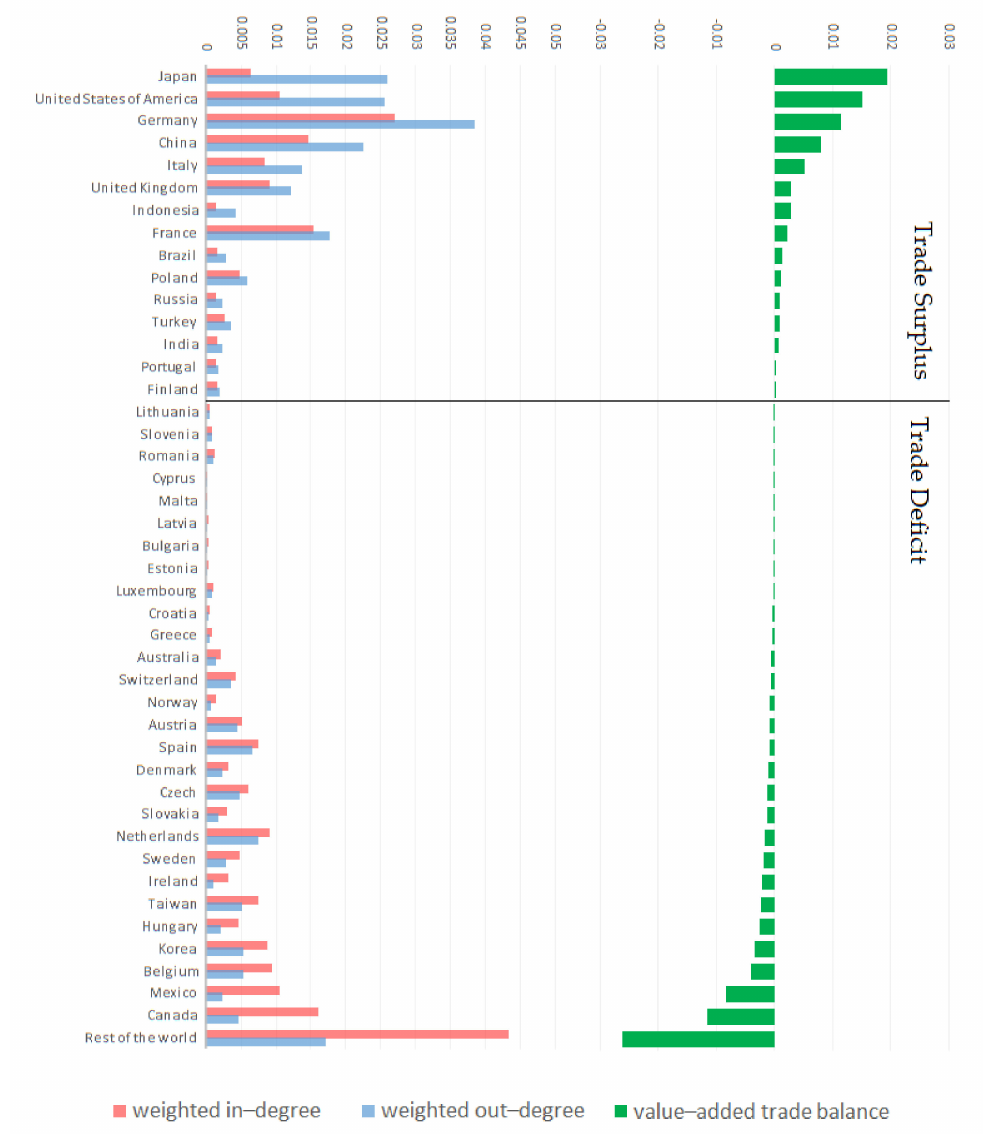
Figure 3. Sectoral GVC network: “Manufacture of rubber and plastic